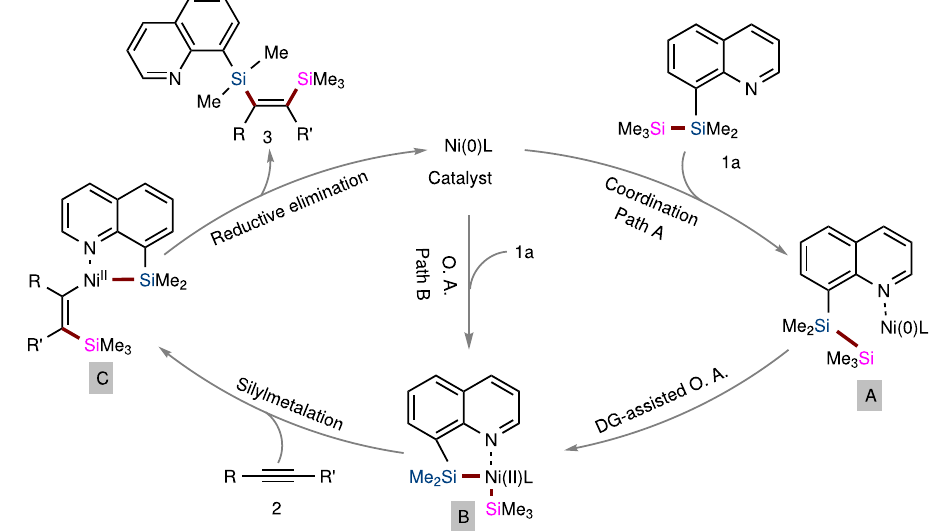
Fig. 8 Proposed catalytic cycle. Speci fi cally, A : transition state by coordination of Ni 0 to the nitrogen atom of disilane TMDQ reagent; B : transition state after oxidative addition of Si − Si bond; C : transition state for silylmetalation of an internal alkyne.